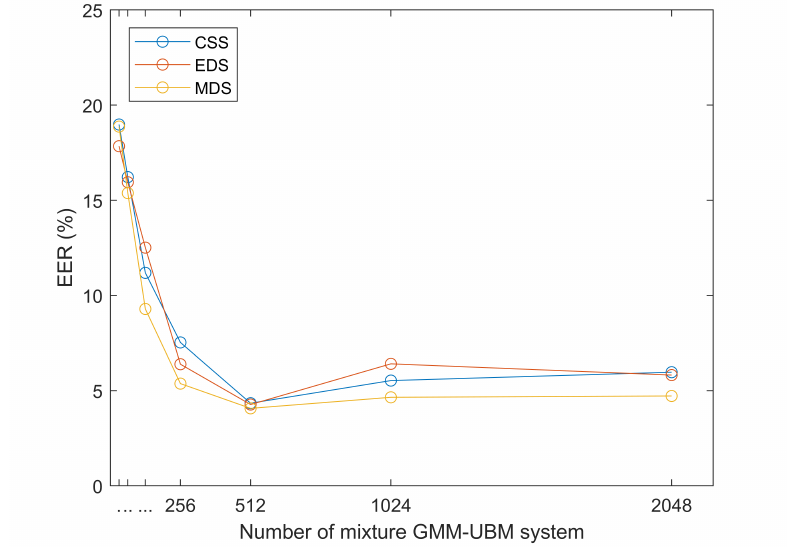
Figure 3. The EER performance of speaker verification system in different number of mixture GMM-UBM system of